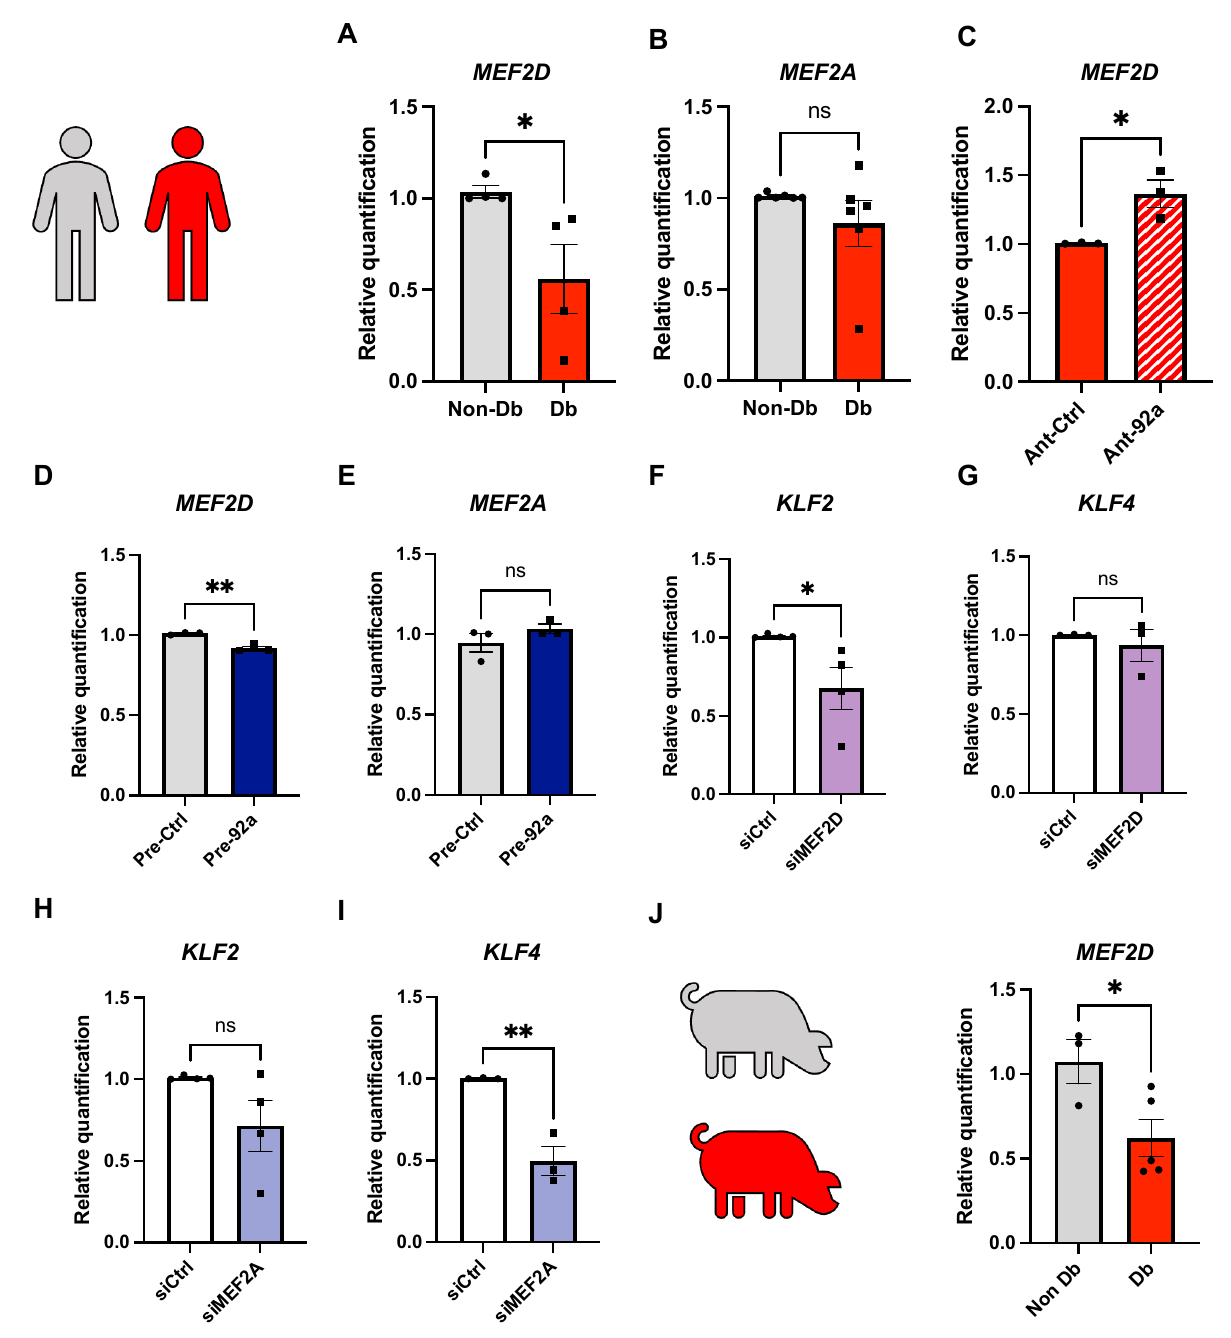
Figure 5. Regulation of MEF2D in diabetes and by miR-92a. ( A , B ) Quantitative PCR analysis of relative expression of MEF2D and MEF2A in nondiabetic vs. diabetic HCMECs ( n = 4), and of ( C ) MEF2D in diabetic HCMECs upon miR-92a antagonism (Ant-92a) relative to its respective control (Ant-Ctrl) ( n = 3). ( D , E ) Quantitative PCR analysis of MEF2D and MEF2A expression in nondiabetic HCMECs upon miR-92a overexpression (pre-92a) relative to controls (pre-Ctrl) ( n = 3). ( F – I ) Quantitative PCR analysis of ( F ) KLF2 and ( G ) KLF4 gene expression upon knockdown of MEF2D and ( H ) KLF2 and ( I ) KLF4 gene expression upon knockdown of MEF2A , each compared to respective controls ( n = 5). ( J ) Quantitative PCR analysis of MEF2D expression in diabetic INS C94Y pigs relative to their nondiabetic littermates ( n = 5). Statistical analyses by unpaired Student’s t -test; * p < 0.05; ** p <